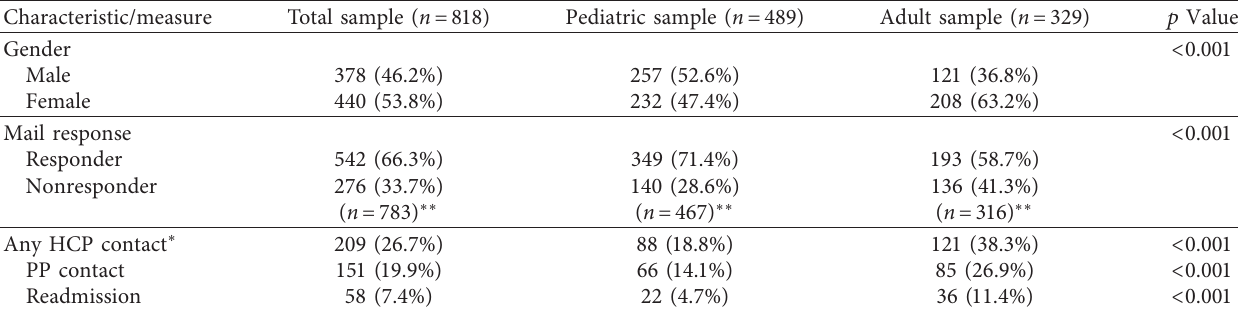
Table 1: Participant gender, mail response rates, and complication rates ∗ by age